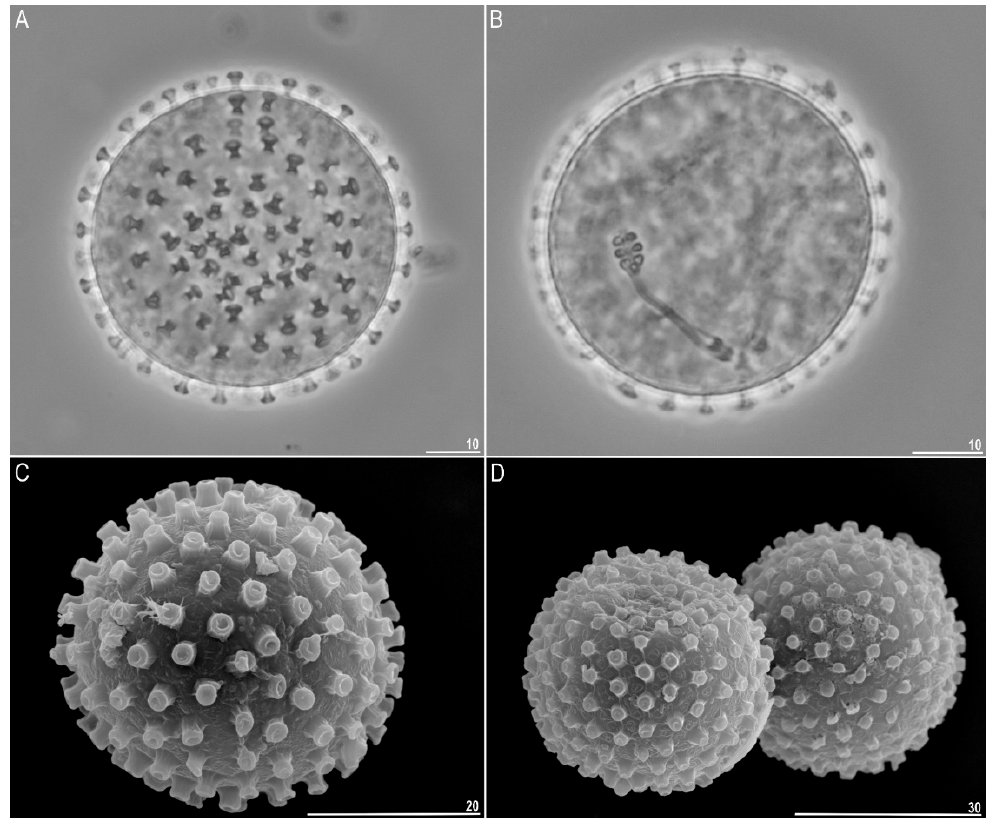
Figure 4. Minibiotus intermedius : ( A ) egg chorion (PCM); ( B ) embryo in the egg (PCM); ( C , D ) egg chorion (SEM). Scale bars in μ m.